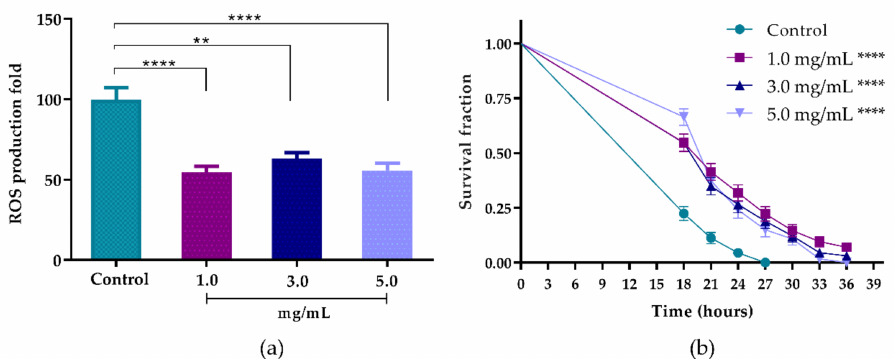
Figure 6. Intracellular levels of ROS and survival rate curve of wild-type N2 worms treated with AsRE. ( a ) ROS production levels after treatment with 1.0, 3.0 and 5.0 mg / mL of AsRE. ( b ) Survival fraction curves of C. elegans under stress conditions after treatment with 1.0, 3.0 and 5.0 mg / mL of AsRE; ** p < 0.01 compared control with 3.0 mg of treatment; **** p < 0.0001 compared control with 1.0 and 3.0 mg of treatment; by one-way ANOVA, followed by a Tukey’s post-test; ( b ) Survival fraction after treatment with 1.0, 3.0 and 5.0 mg / mL of extract. Survival was measured every 3 h at 25 ◦ C; **** p < 0.0001, compared to the control with worms treated by log-rank (Mantel–Cox) test.